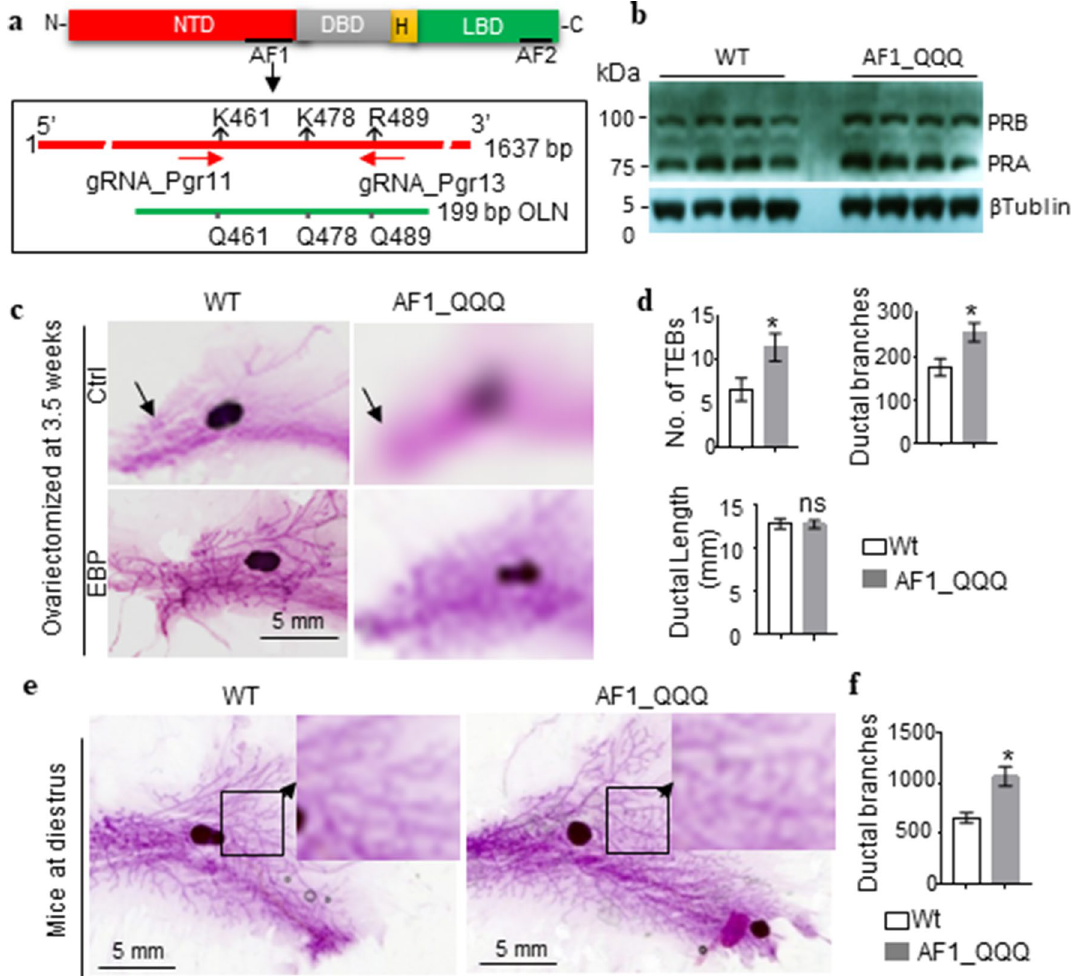
Figure 1. AF1_QQQ mutations promote mammary development in response to estrogen and progesterone. ( a ) Domain structure of PGR and CRISPR-Cas9 gene editing strategy. The red bar indicates exon 1 of Pgr gene (1–1671 bp). Cas9 mRNA, 2 Pgr gRNAs and the homologous single-stranded oligonucleotide (OLN) containing the 3 mutations were injected into the pronuclei for mutant generation. ( b ) AF1_QQQ mutations did not significantly affected PGR levels in estrogen-treated ovariectomized mice. ( c , d ) AF1_QQQ mice show greater number of TEB and ductal branching in response to EBP. Mice were ovariectomized at 3.5 weeks old. After 2 weeks, the mice were treated with control vehicle (Ctrl) or EBP for 16 days. ( c ) Representative whole mount images of mammary gland. Rudimentary mammary ducts in Ctrl are indicated by arrows. ( d ) Quantification of TEBs, mammary ductal branches and ductal length from the whole mount images of EBP-treated mammary gland (mean ± SEM, *p < 0.05, n = 6). The vehicle-treated mammary gland only contains a few rudimentary ducts and were therefore not quantified. ( e , f ) AF1_QQQ mice at dioestrus also show greater number of mammary ductal branching than the WT mice. ( e ) Representative whole mount mammary images with enlarged insets to show greater details. ( f ) Quantification of ductal branching (results are expressed as mean ± SEM, n = 6, *p <